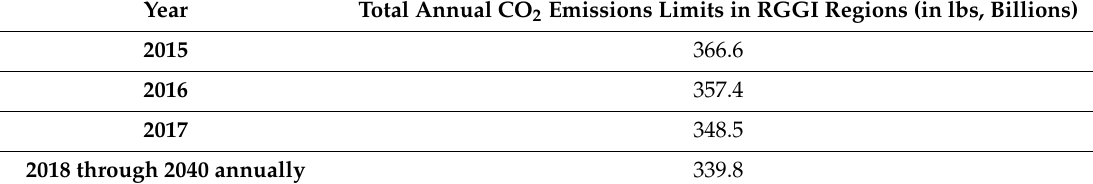
Table A6. Regional Greenhouse Gas Initiative (RGGI) CO 2 Emissions Limits.